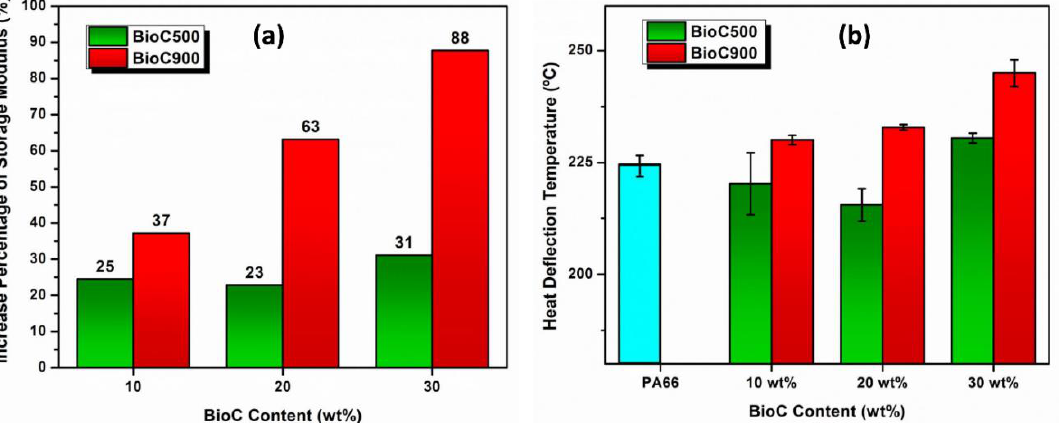
Figure 8. ( a ) Percentage increase in storage modulus over neat PA66. ( b ) Heat deflection temperature of BioC500/PA66 and BioC900/PA66